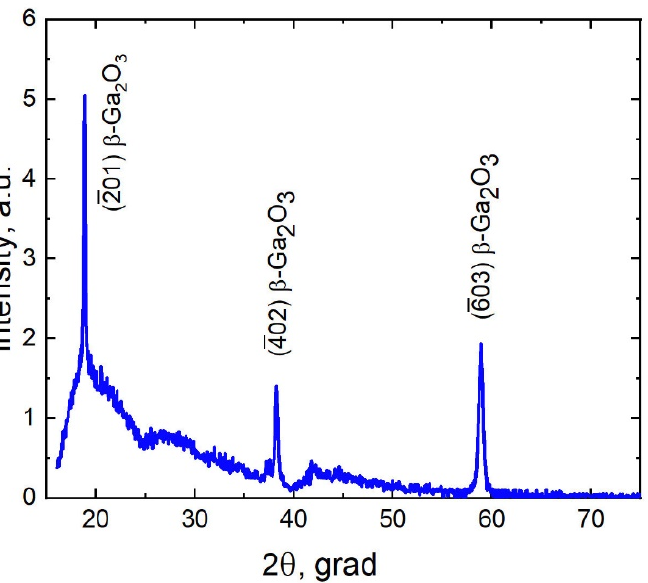
Figure 3. XRD spectrum of a 𝛽 -Ga 2 O 3 sample grown on the 3C-SiC(111)/Si(111) hybrid substrate at 900 °C.